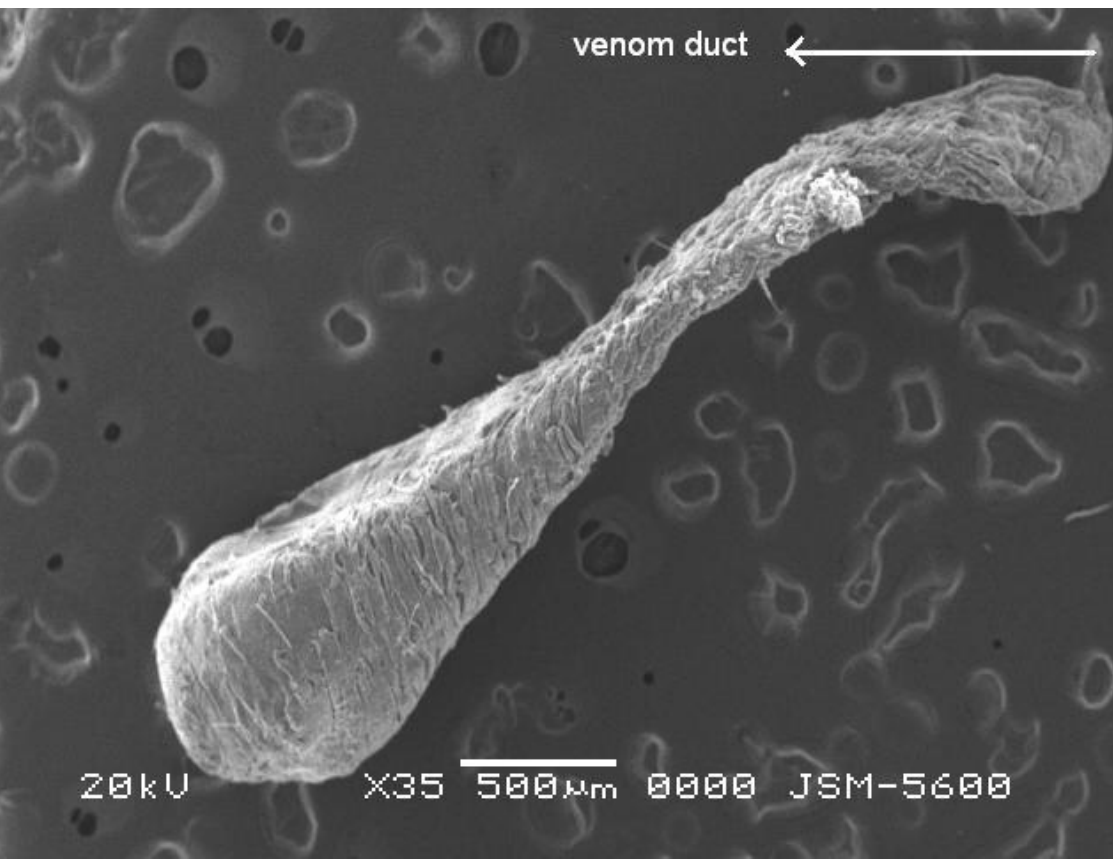
Figure 5. L. singoriensis venom gland covered with muscle